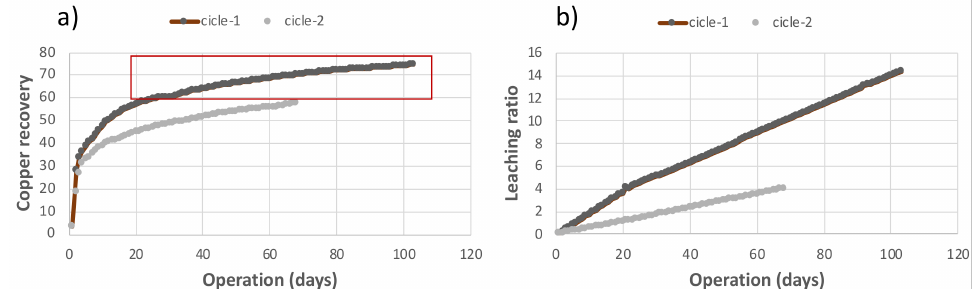
Figure 3. Examples of two copper recovery cycles and their relationship with variable X7. ( a ) shows levels of leaching ratio for cicle-1 and cicle-2, while ( b ) shows the different values of the variable Y influenced by X7 throughout each leaching